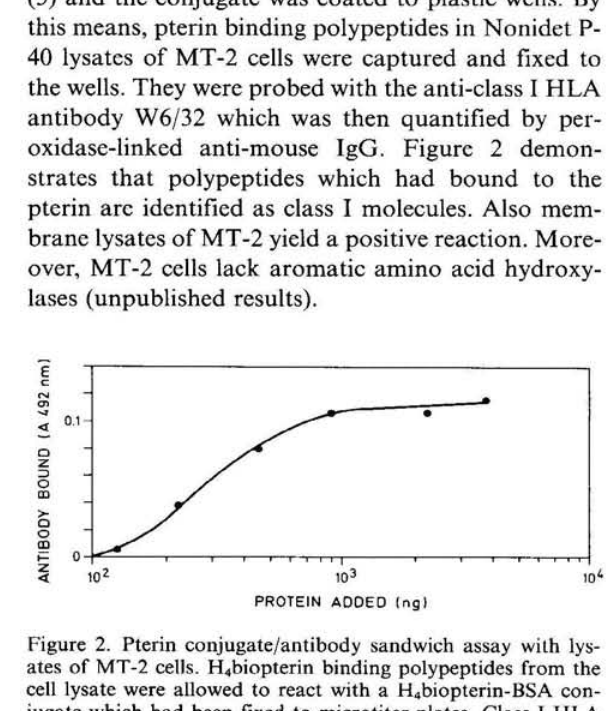
Figure 2. Pterin conjugate/antibody sandwich assay with lys- ates of MT-2 cells. H 4 biopterin binding polypeptides from the cell lysate were allowed to react with a H 4 biopterin-BSA con- jugate which had been fixed to microtiter plates. Class I HLA antigen was then determined by the monoclonal antibody W6/32. BSA coating served as a control for unspecific binding. Unspecific staining was determined by Daudi cell lysates and was subtracted.